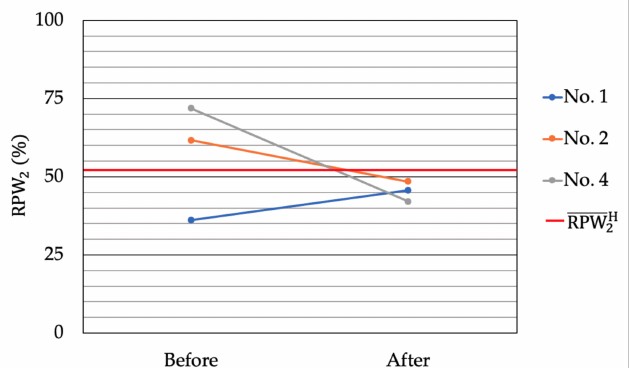
Figure 8. Results of RPW 2 before and after applying local vibratory stimulation to the muscle spindles (higher frequency). RPW 2 indicates the relative proprioceptive weighting ratio of mus- cle spindles (higher frequency), and RPW H 2 indicates the mean value of RPW 2 for healthy adults (Supplemental Table S2).